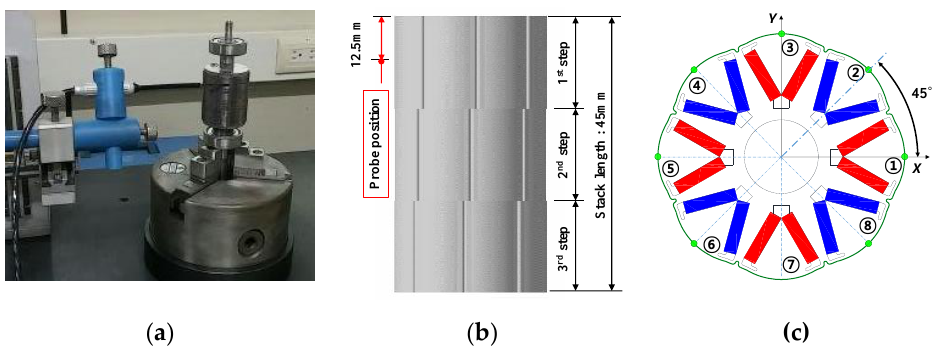
Figure 5. Measurement equipment and position for the flux density on the rotor surface: ( a ) measurement equipment; ( b ) measurement position into axial direction; and ( c ) measurement position into radial direction.